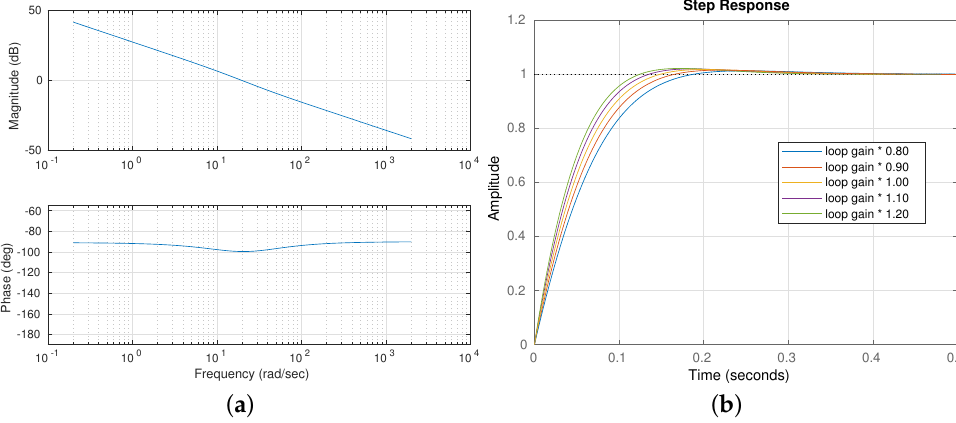
Figure 13. Open loop Bode diagram ( a ) and closed loop time response ( b ) for the integer order (IOPI)